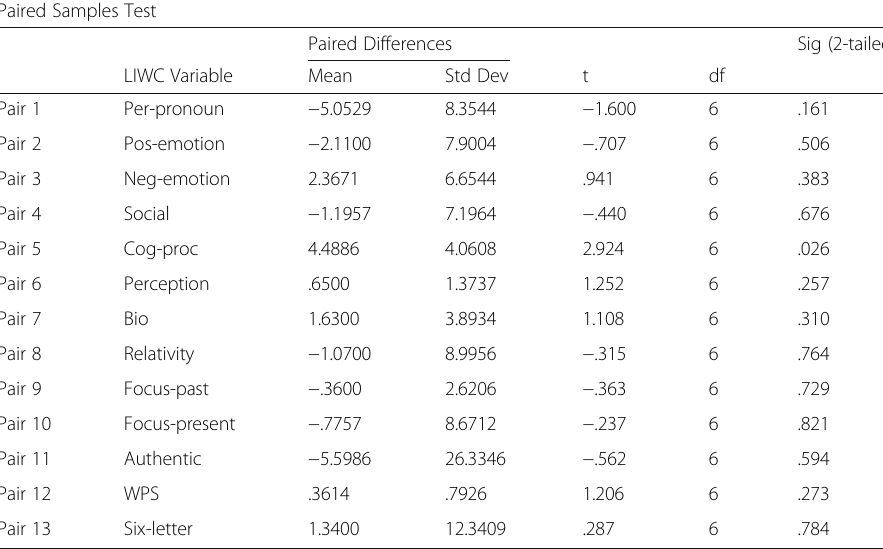
Table 5 LIWC social presence measures before/after intervention